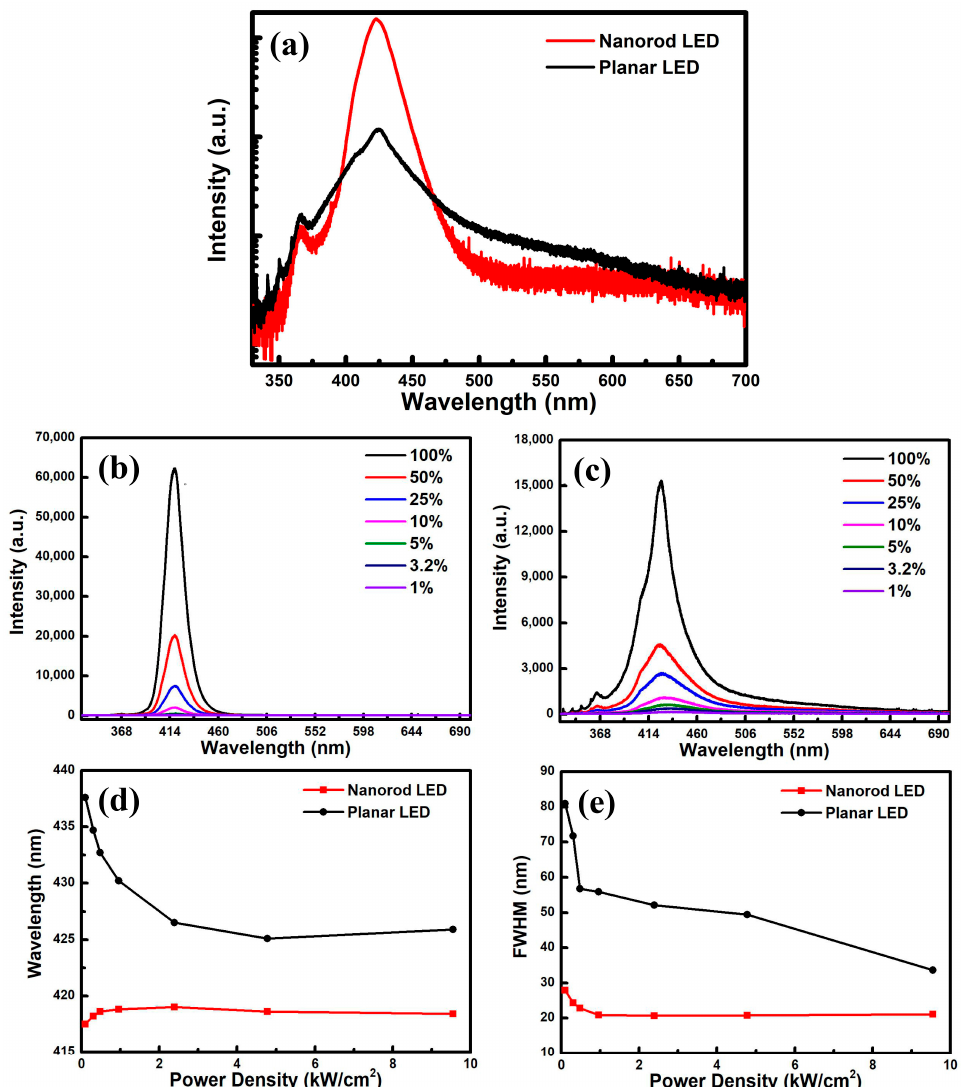
Figure 4. ( a ) The PL spectrum of the GaN/ β -Ga 2 O 3 planar and nanorod LED in logarithmic coordinates. The PL spectrum of the GaN/ β -Ga 2 O 3 ( b ) nanorod and ( c ) planar LED under the different excitation power densities which increases from 1% to 100%. ( d ) The PL peak wavelength position and ( e ) the PL peak FWHM of the nanorod and planar LED as a function of the excitation power density.